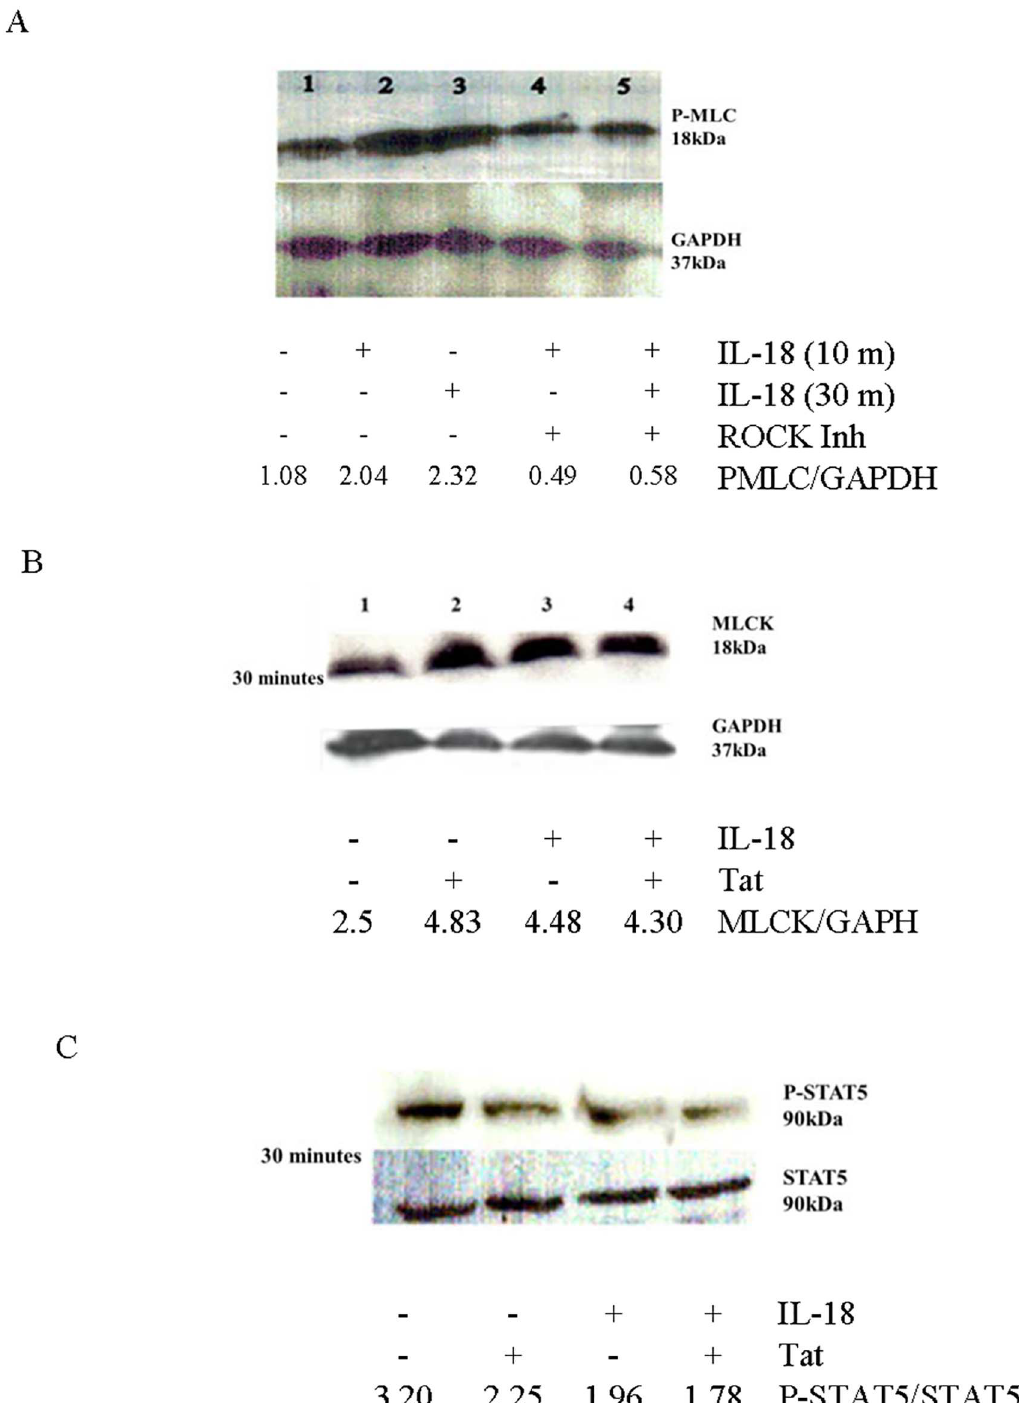
Fig 12. IL-18 increases expression of MLCK and pMLC via ROCK, and decreases that of phosphorylated STAT-5. HT29 cell monolayers were treated with IL-18 (10 ng/ml) and/or Tat (100 ng/ml) with or without a cell permeable inhibitor of ROCK (GSK429286A, 10μM; added 30 minutes prior to the addition of the cytokine). At the indicated time points, the cells were lysed. About 25 ug of the lysate proteins were resolved on SDS-PAGE and the Western blots were performed. Panel A shows results of a representative of three experiments for the expression of p-MLC. Panel B shows expression of MLCK after treatment of the monolayers with IL-18 (10 ng per ml) and/or with Tat (100 ng/ml) after 30 minutes. Panel C shows expression of pSTAT-5 and STAT-5 from IL-18 (10 ng per ml) and/or with Tat (100 ng per ml)-treated cells.